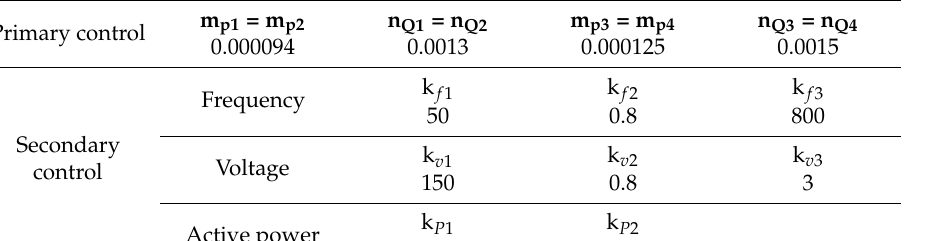
Table 2. Parameters of the primary and secondary control.